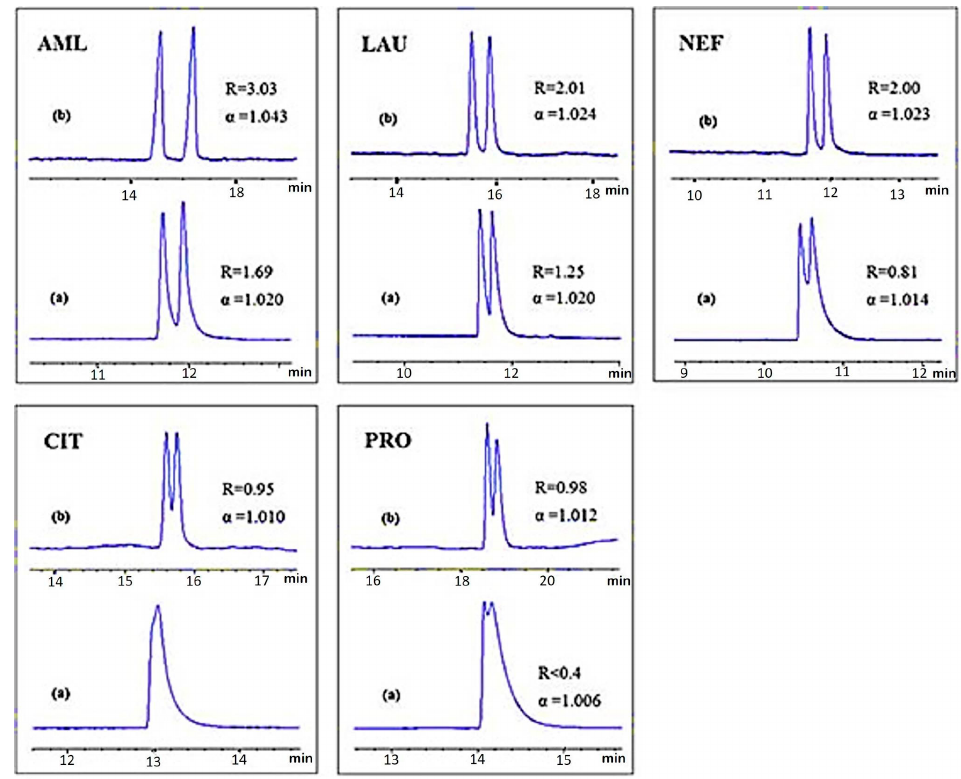
Figure 7. Effect of ionic liquid coated-MWCNTs on the enantioseparation of five drug enantiomers PRO: propranolol, AML: amlodipine, LAU: laudanosine, NEF: nefopam, CIT: citalopram “Reproduced with permission from Q. Zhang et al. [115]. Copyright Wiley, 2014”. ( a ) In the absence of ILs-MWCNTs in the running buffer; ( b ) In the presence of ILs-MWCNTs in the running buffer. Nanomaterials 2017 , 7 , 186